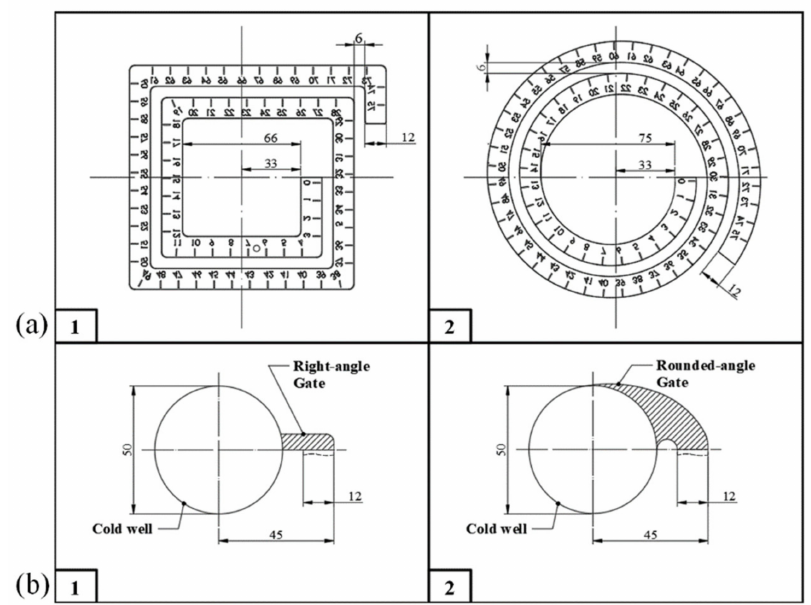
Figure 1. ( a ) Schematic of the flow length specimens (1 mm and 3 mm thick) and different melt fill paths: ( 1 ) square and ( 2 ) round. ( b ) Flow length specimens with different gate designs: ( 1 ) right- angular and ( 2 )